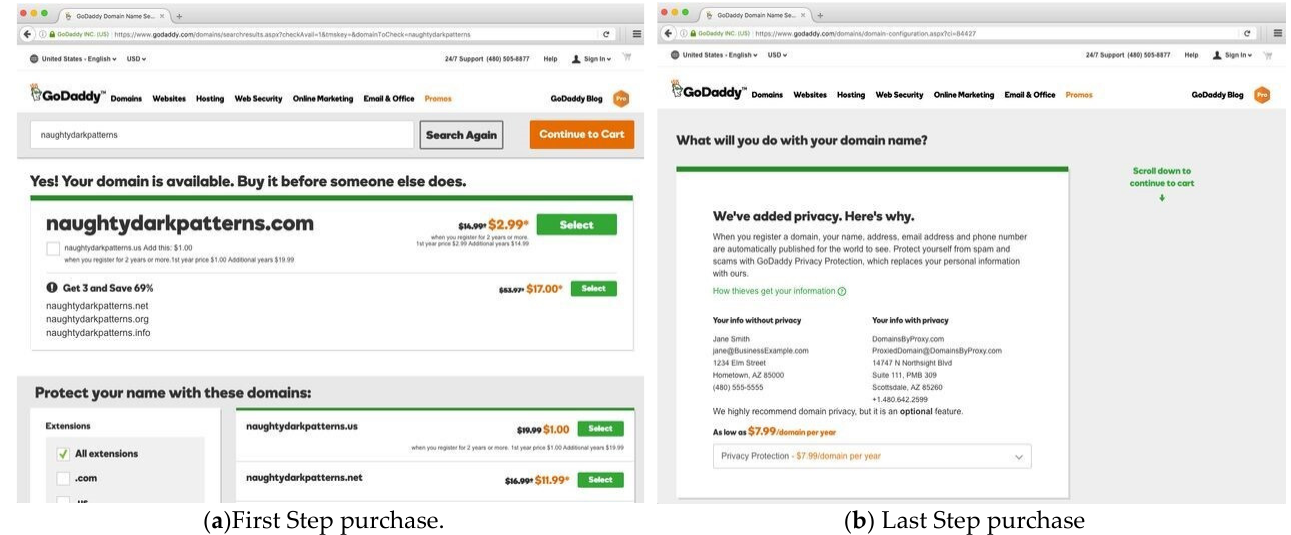
Figure 1. «Add to cart» dark pattern on godaddy (https://www.godaddy.com/. accessed on 12 May 2022)